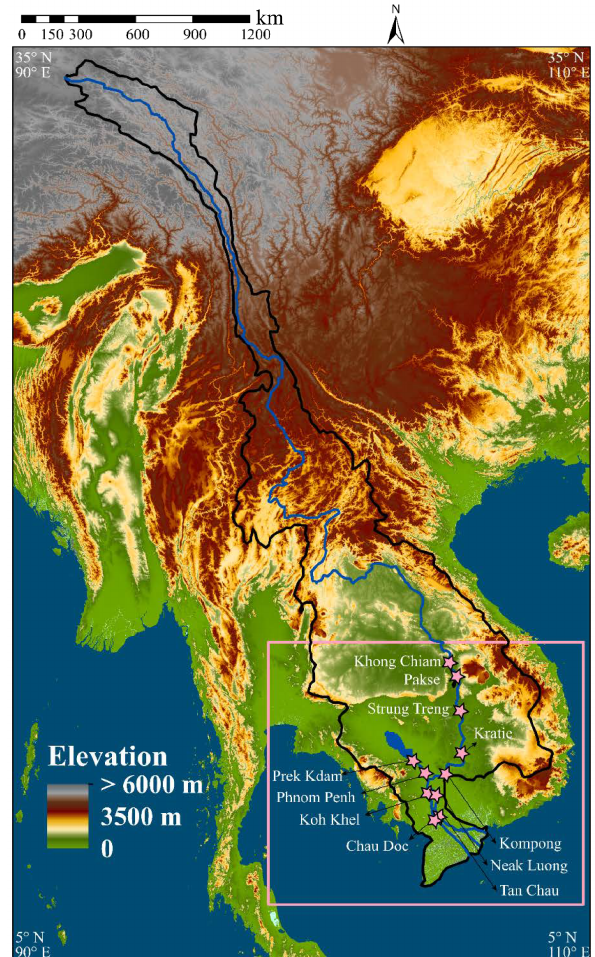
Figure 1. Map and digital elevation of the Mekong River basin (area = 795000km 2 ) and its delta. The study area is delineated by a pink rectangle. The 11 stations (from Mekong River Commission) that monitor the water level are also marked by pink